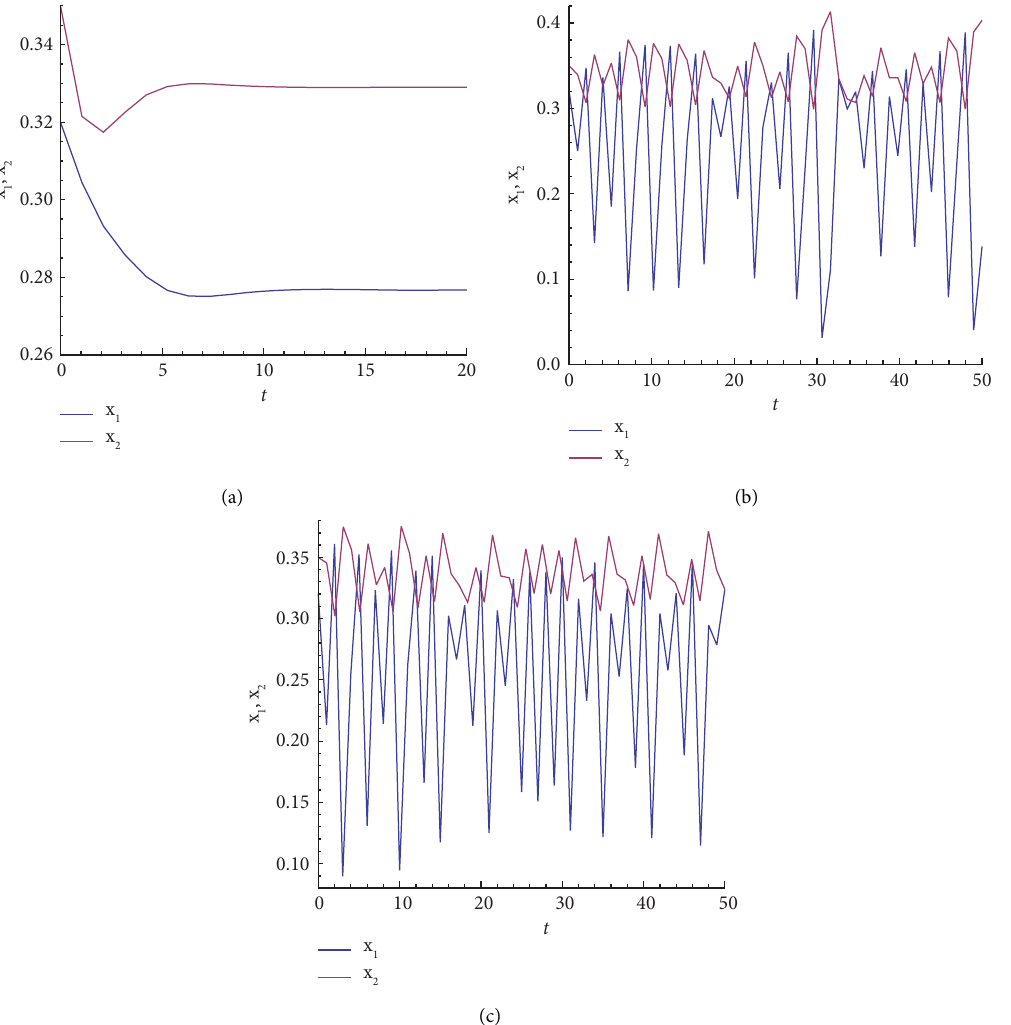
Figure 2: Te trajectory of time at diferent α